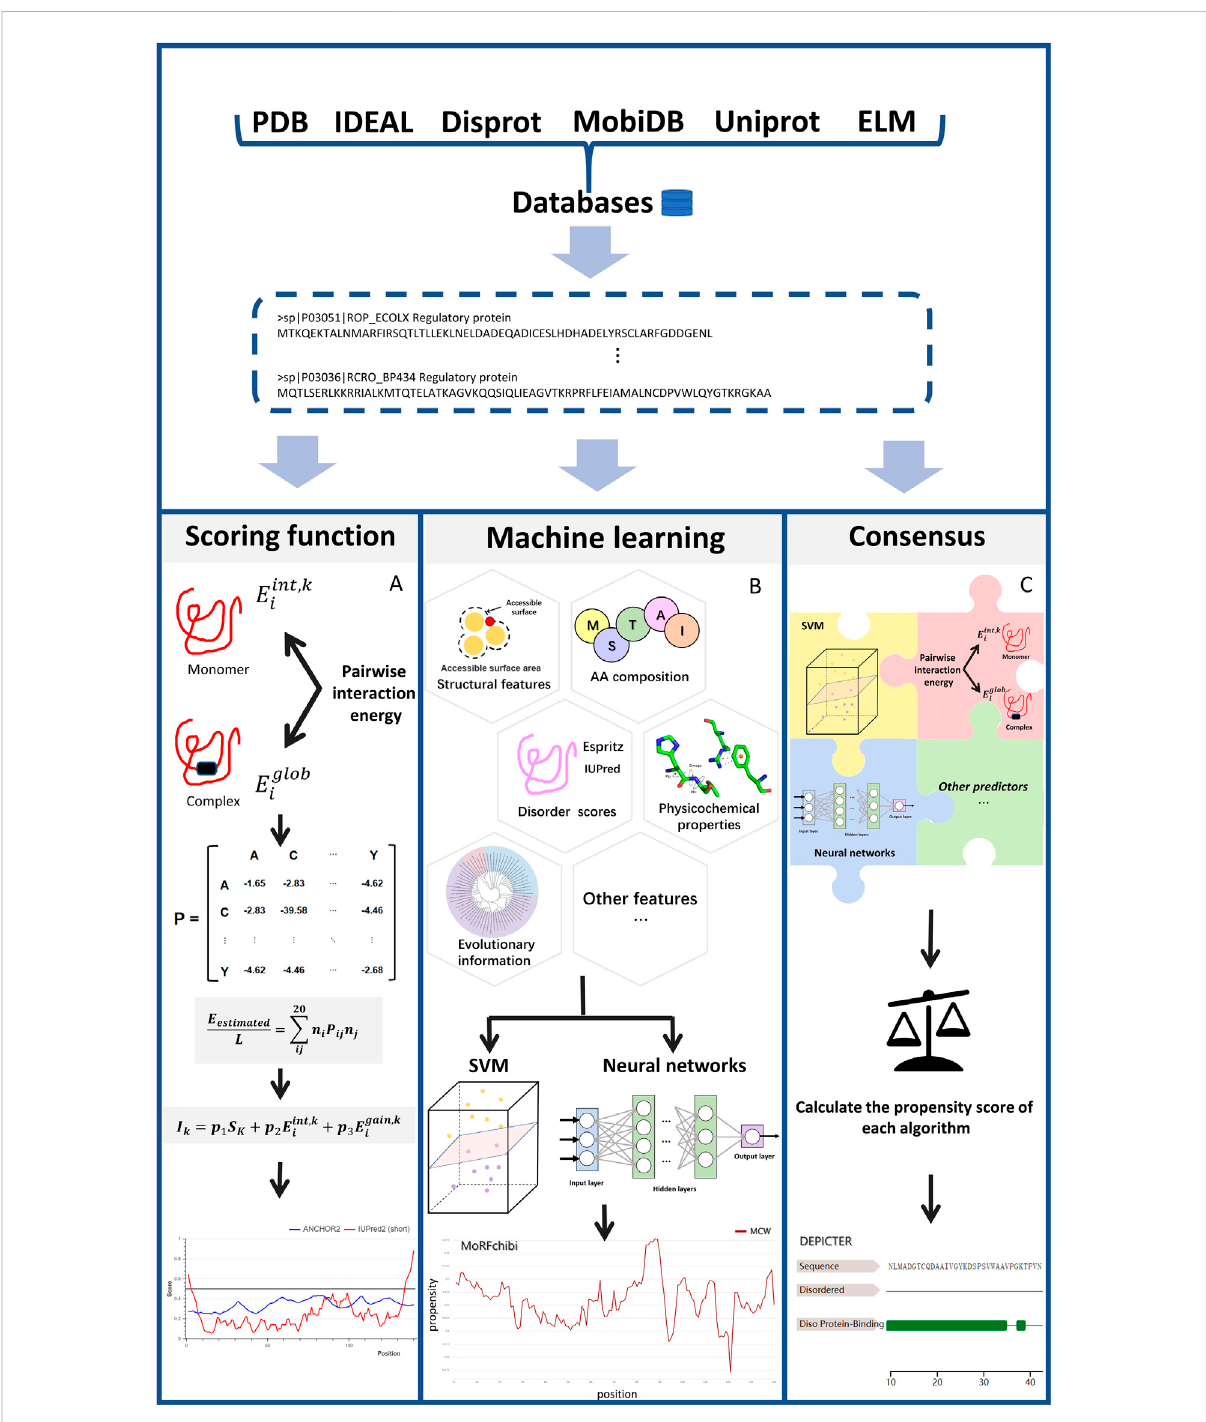
FIGURE 1 The work fl ow of each type of methods Figure 1 illustrates main three categories described in this article: (A) scoring function-based methods (B) machine learning-based methods and (C) consensus-based methods. The key steps for each type of methods are depicted in the diagram. Scoring function-based methods in (A) , we use ANCHOR work fl ow to represent how scoring function works. Machine learning-based methods performthepredictionusingvarioustypesofmachinelearningmodelslikeSVMandNeuralNetworkbasedonfeaturesextractedfromdifferent perspectives. Consensus-based methods can predict IDP binding site by weighting different prediction models and combining them optimally. The fi nal results show in (A) was processed by (Mészáros et al., 2018). The fi nal results show in (B) was processed by (Malhis et al., 2016), The fi nal results show in (C) was processed by (Barik et al.,